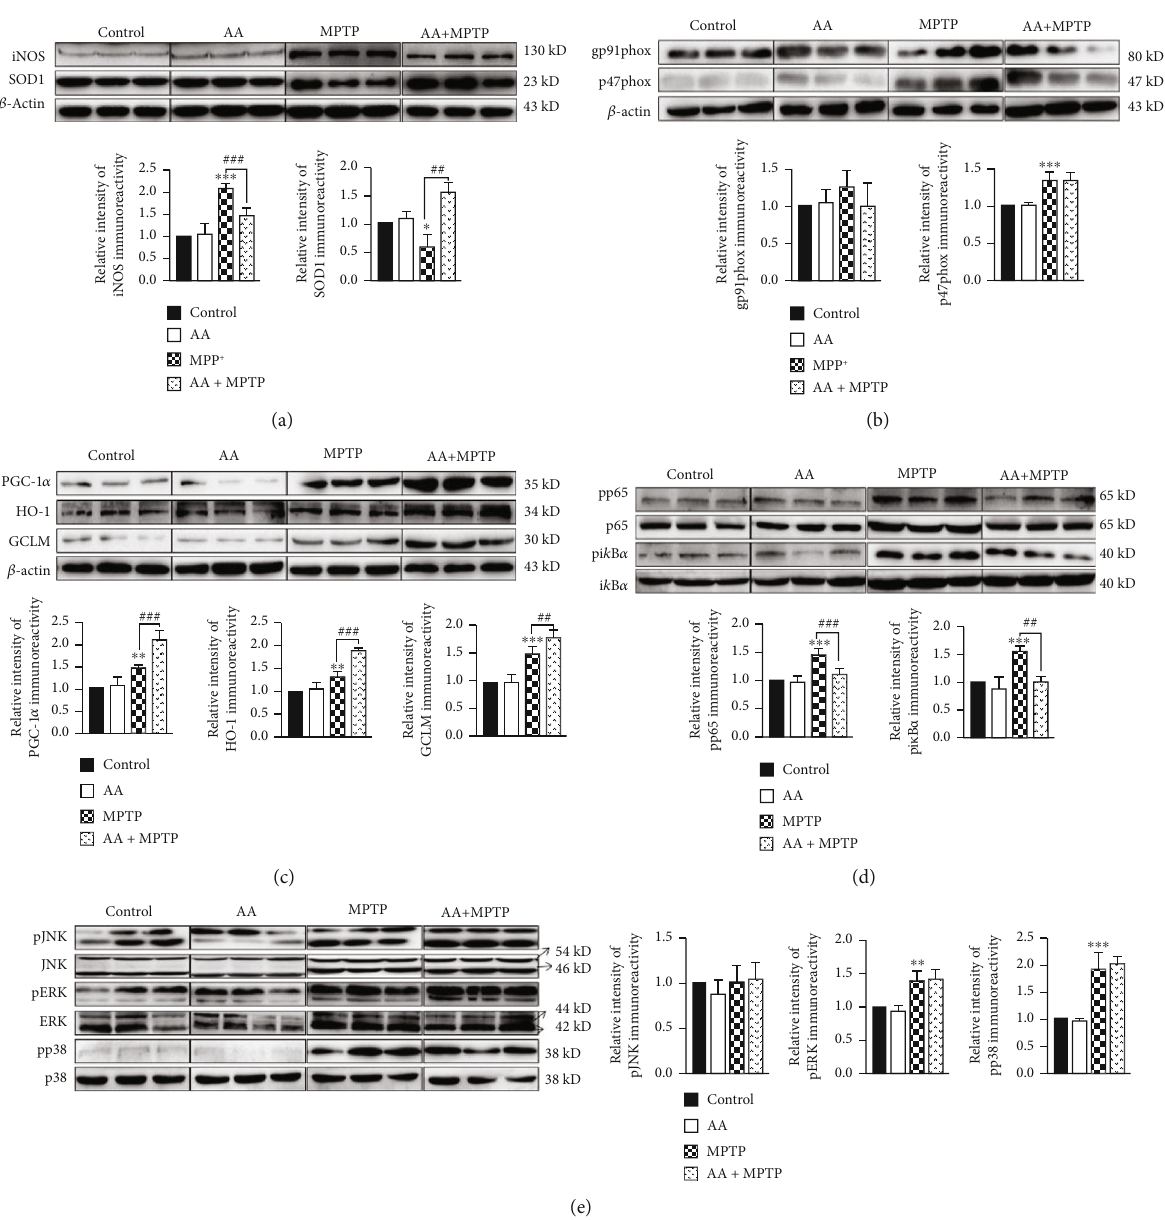
Figure 6: Ascorbic acid enhances antioxidant function and decreases NK- κ B activation in the midbrains of MPTP-treated mice. Wild-type mice were intraperitoneally treated with 500 mg/kg of AA for 60 days, following by coinjected with 25 mg/kg of MPTP every 3.5 days for fi ve weeks. After behavioral testing, midbrains were removed and total proteins were extracted. (a) The expression levels of iNOS and SOD1 were detected by Western blotting ( n = 3 ). (b) The expression of gp9phox and p47phox was detected by Western blotting ( n = 3 ). (c) The expression levels of PGC-1 α , HO-1, and GCLM were detected by Western blotting ( n = 3 ). (d) The expression levels of phosphorylated p65 and i κ B α were detected by Western blotting ( n = 3 ). (e) The expression levels of phosphorylated JNK, ERK, and p38 were detected by Western blotting ( n = 3 ). Data were obtained from three independent experiments. One-way ANOVAs followed by LSD pairwise comparisons were performed. ∗ was considered signi fi cant compared to control ( ∗ P < 0 : 05 , ∗∗ P < 0 : 01 , and ∗∗∗ P < 0 : 001 ). # was considered signi fi cant compared to MPTP or MPP + ( # P < 0 : 05 , ## P < 0 : 01 , and ### P < 0 : 001